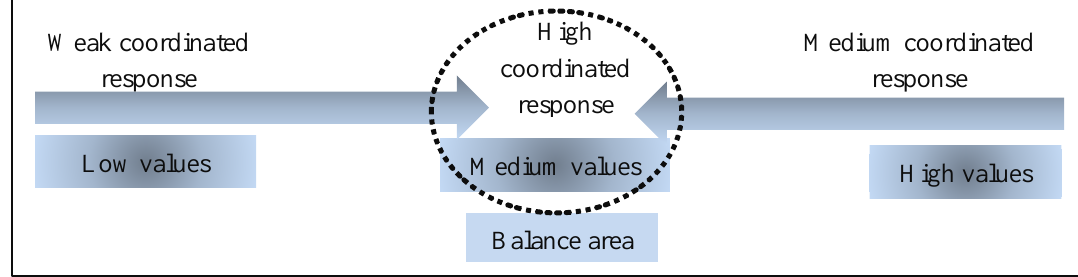
Fig. 8. The scale used in evaluating the